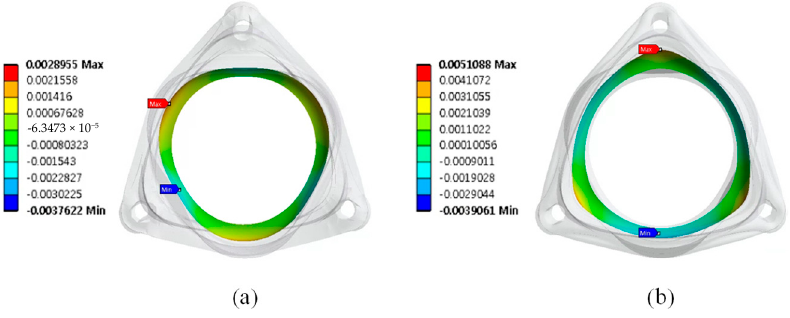
Figure 12. Radial deformation in the outer ring raceway: ( a ) inboard row and ( b ) outboard row.